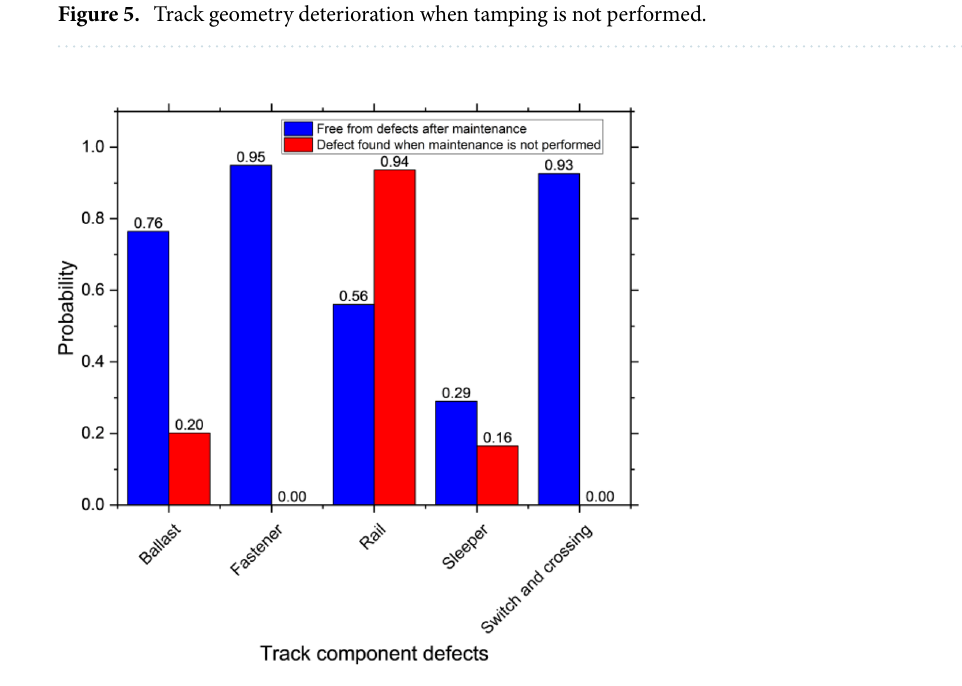
Figure 6. Relationship between defect occurrence and rail